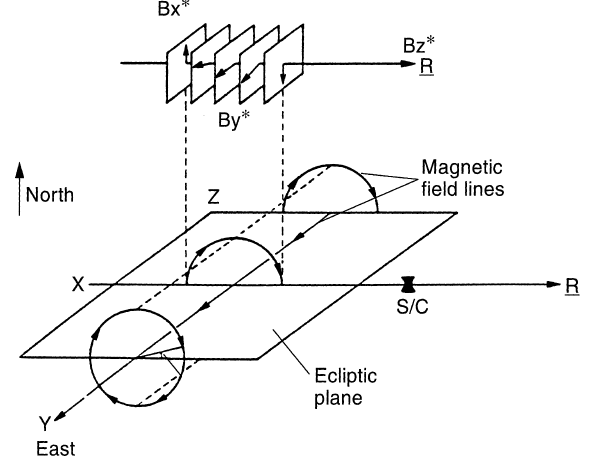
Fig. 3. Idealized sketch showing the expected magnetic field signatures during passage of a large-scale cylindrical magnetic flux tube over a s/c (adapted from Goldstein, 1993). B (cid:3) maximum, intermediate and minimum variance of the magnetic field vector. The south to north [ (cid:255) B (cid:3) magnetic field vector is associated with passage of the circular field lines at the cloud’s outer boundaries. At the center of the flux tube (at the axis) the magnetic field is directed along the (cid:135) B (cid:3) A semicircular rotation appears when B (cid:3) diagram )